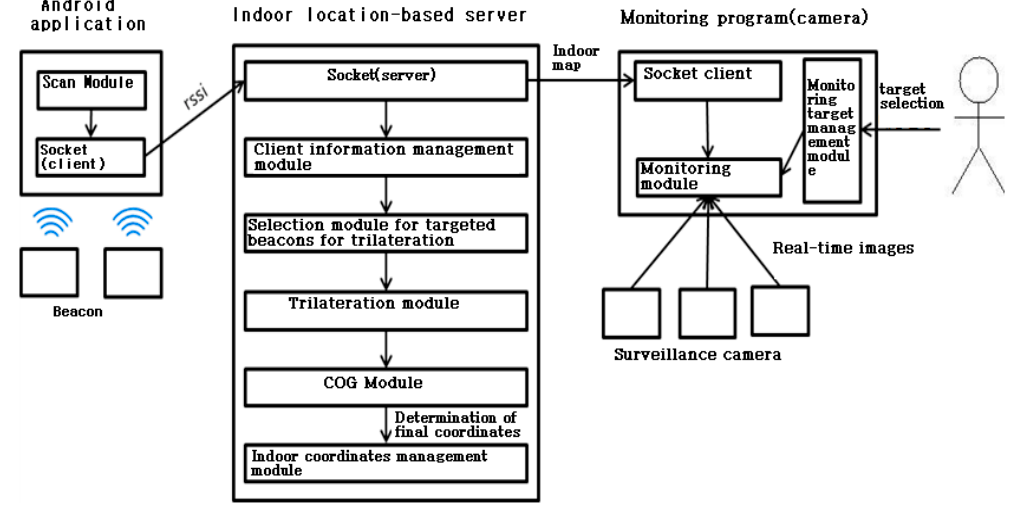
Figure 6. The schematic of indoor location-based control system. Figure 6. The Schematic of Indoor Location-based Control System.